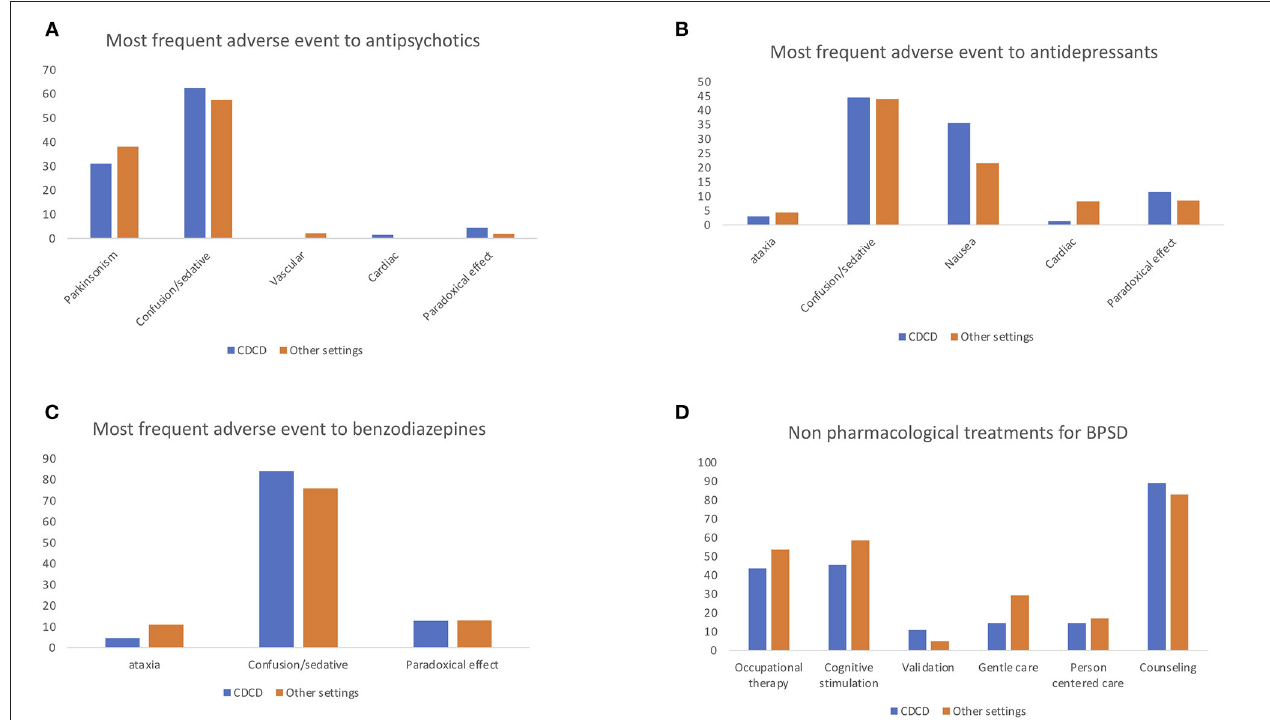
FIGURE 2 | Answer differences between CDCD and non-CDCD setting: perceived most frequent side effects of antipsychotics (A) , antidepressants (B) , benzodiazepines (C) , and use of non-pharmacological approach to treat BPSD (D)